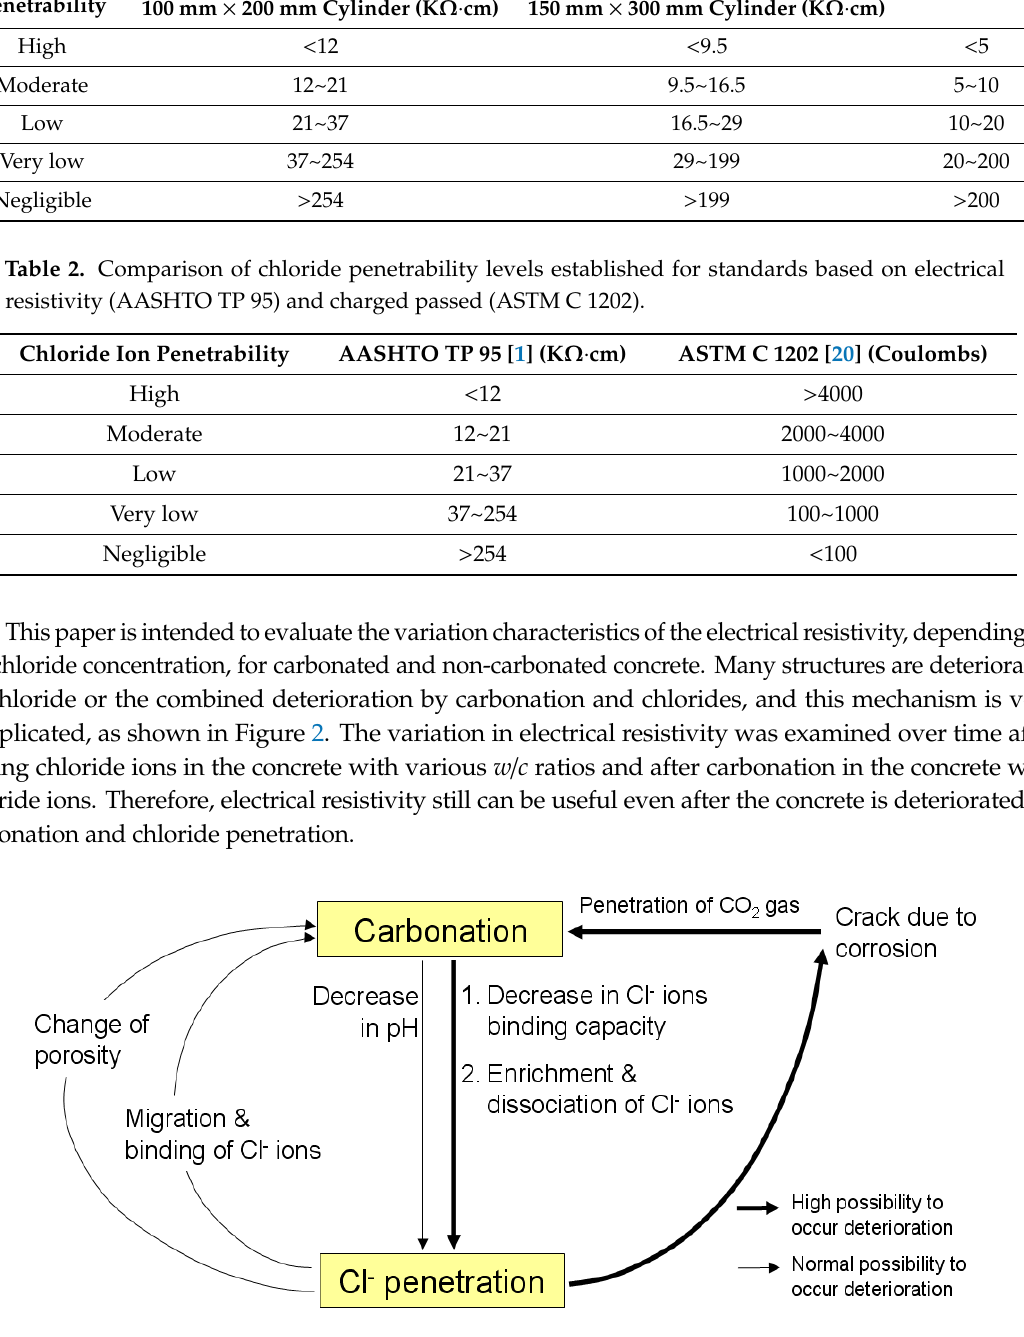
Table 1. Chloride ions penetrability.